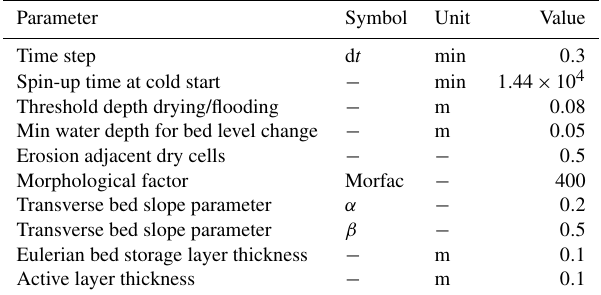
Table 2. Parameters for processes and numerics.